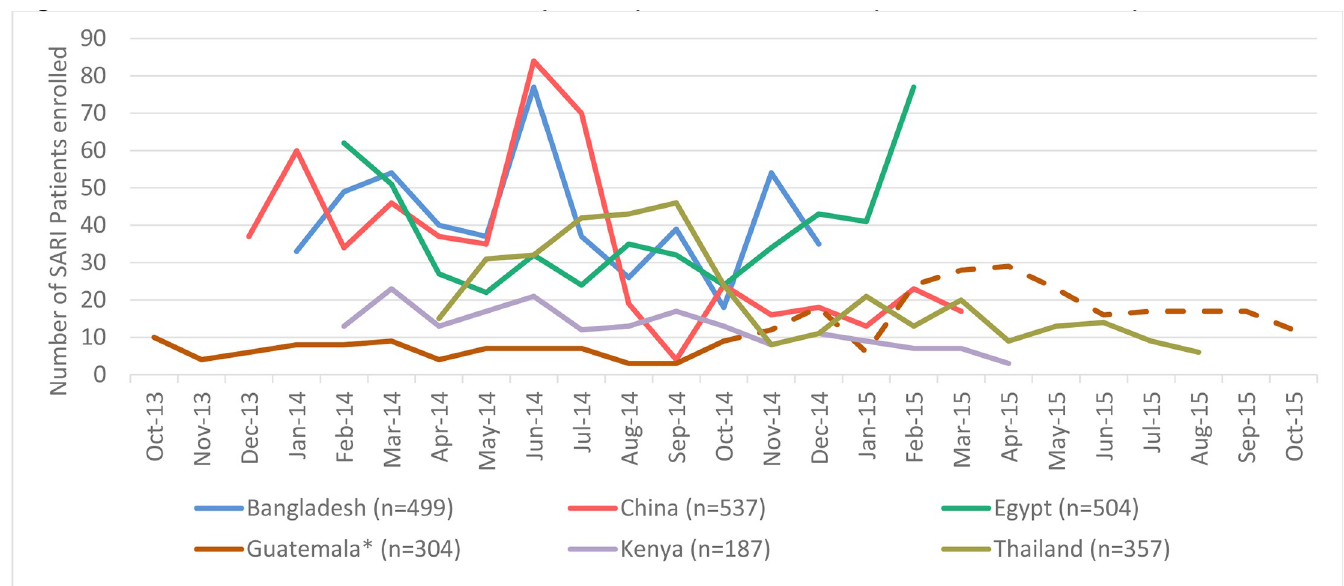
Fig 1. Numbers of severe acute respiratory infection (SARI) patients enrolled by week and site. � Temporary suspension of enrollment for 6 weeks in August- September 2014. �� Dotted line indicates time when additional hospital added to surveillance in Guatemala in October 2014.